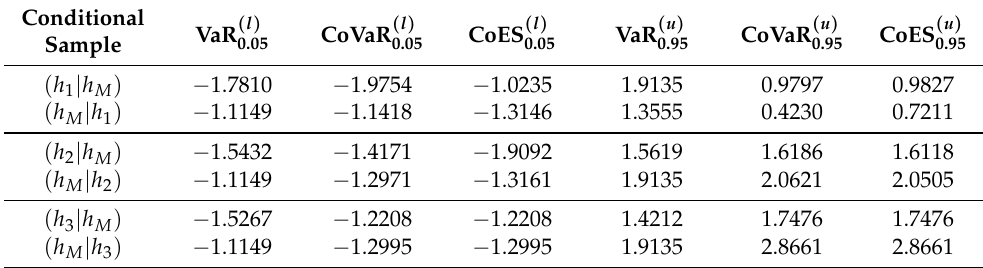
Table A7. CoVaR and CoES measures between the two vectors of